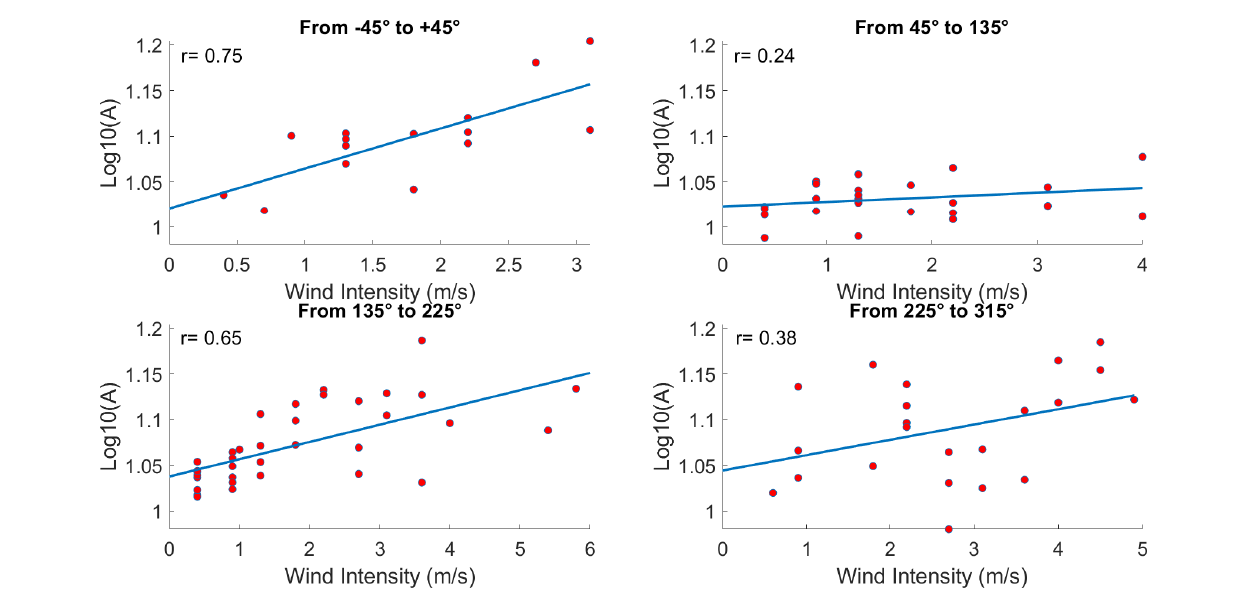
Figure 11. Correlation factor in the sand mask ( r in the figures) between wind amplitude (VH polarization) and wind speed for different wind direction: up left ( − 45°–45°); upper right (45°–135°); bottom left (135°–225°); bottom right